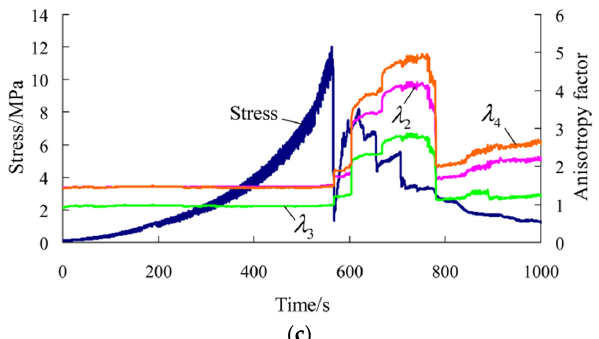
Figure 7. Stress ‐ time curve and time ‐ varying curve of the anisotropy factor in each direction during the whole process of uniaxial compression for rock samples parallel to the bedding direction. ( a ) Rock sample 6-1; ( b ) Rock sample 7-1; ( c ) Rock sample 7-3.